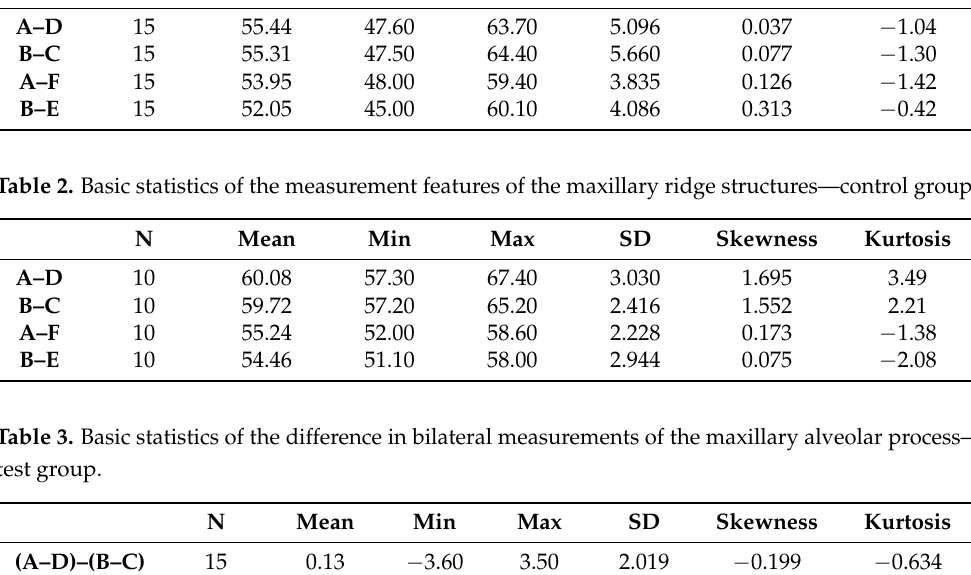
Table 1. Basic statistics of the measurement features of the maxillary ridge structures—test group. N